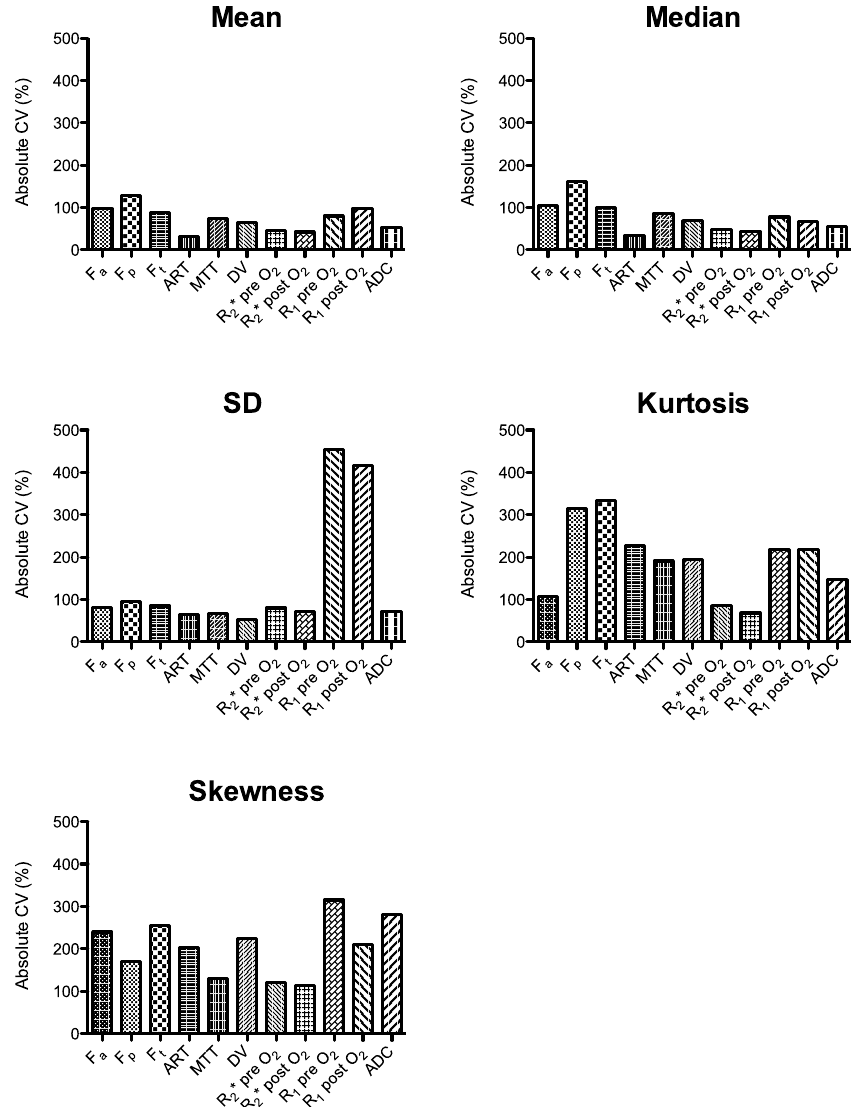
Figure 3. Inter-tumour variability in MRI parameters. Absolute coefficients of variation (CV) of mean, median, SD, kurtosis and skewness parameter values across 39 HCC tumours (in 32 patients). Kurtosis and skewness showed a substantially higher inter-tumour variability compared to mean and median values. ADC = apparent diffusion coefficient, ART = arterial fraction, DV = distribution volume, F a = arterial flow, F p = portal flow, F t = total flow, MTT = mean transit time, R 1 = longitudinal relaxation rate, R 2 * = transverse relaxation